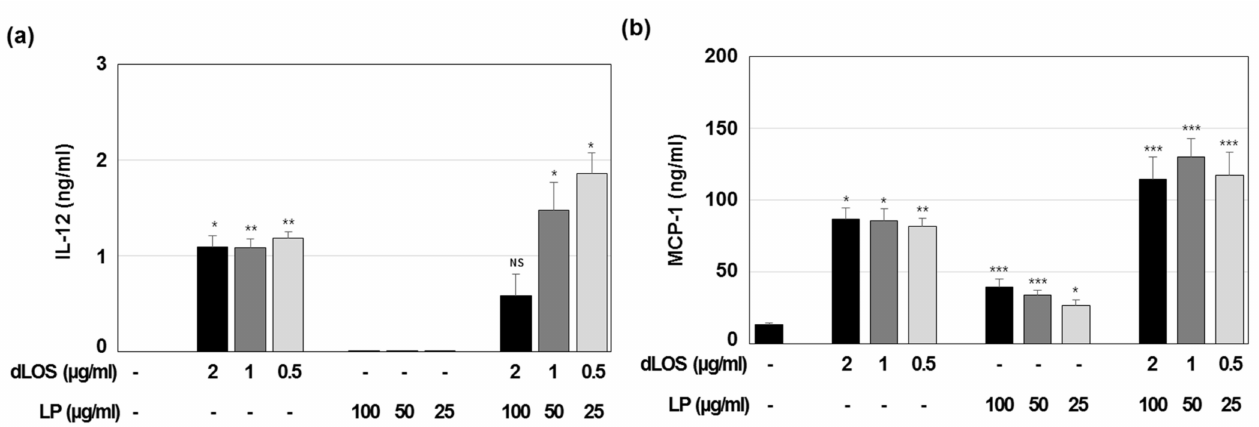
Figure 6. In vitro immune-stimulating activity of liposomes (LP). J774A.1 cells were cultured with liposomes, dLOS, or both for 24 h. IL-12 ( a ) and MCP-1 ( b ) released into the culture medium were measured by sandwich ELISA. Results are expressed as mean ± SD of triplicate cultures. Data presented are representative of at least two experiments with similar results. * p < 0.05; ** p < 0.01; *** p < 0.001 as compared with control